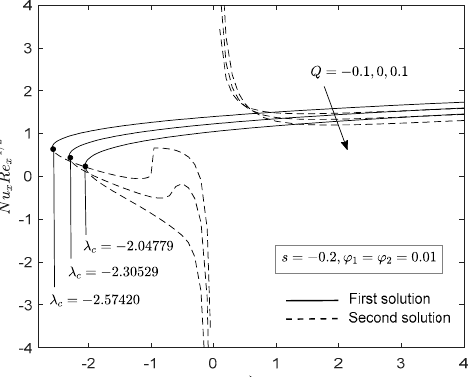
Figure 13. Nu x Re − 1/2 x for selected value of heat generation/absorption when s = − 0.2. Nu − 0.2 s = − . Figure 13. 1/2 Re x x